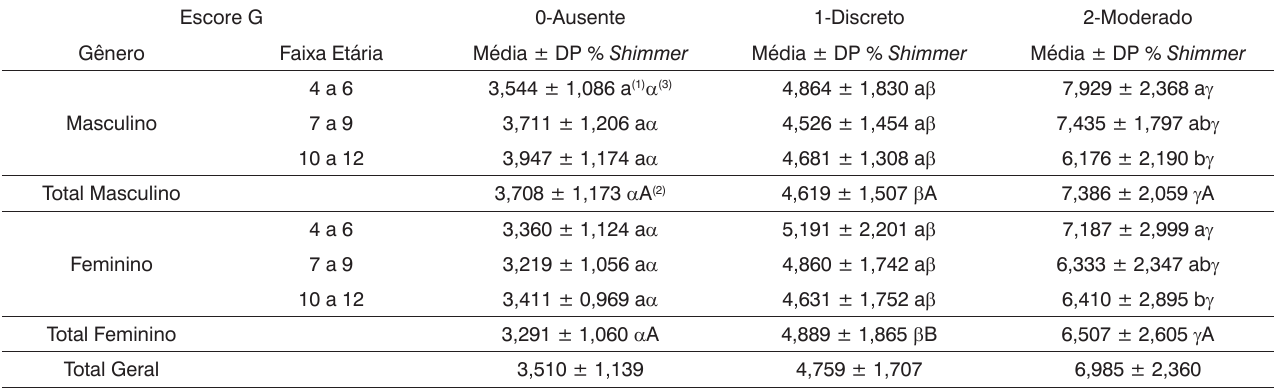
Tabela 9. Valores médios e desvio padrão (DP) da % de shimmer e correlação com o escore do parâmetro G da escala GRBASI, o gênero e a faixa etária (em anos).